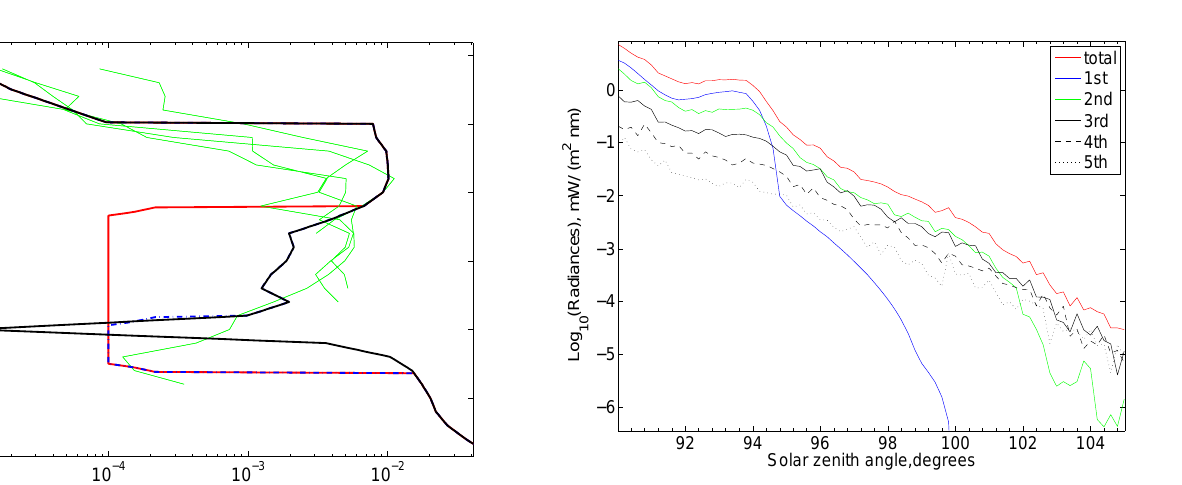
Fig. 16. Contributions of different orders of scattering in the first and the second purple